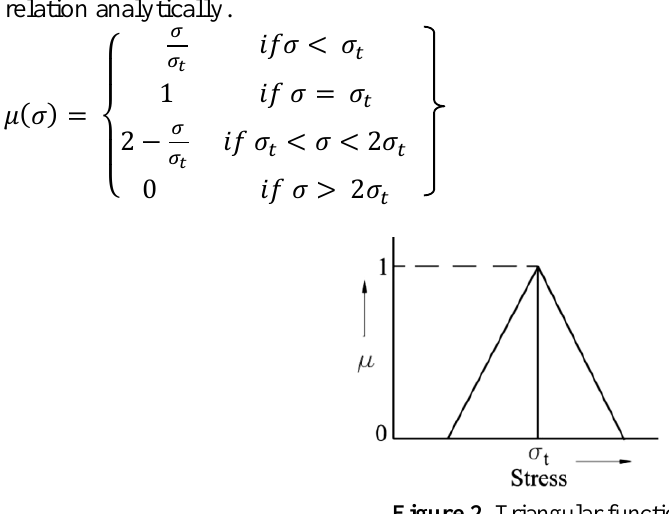
Figure 2. Triangular